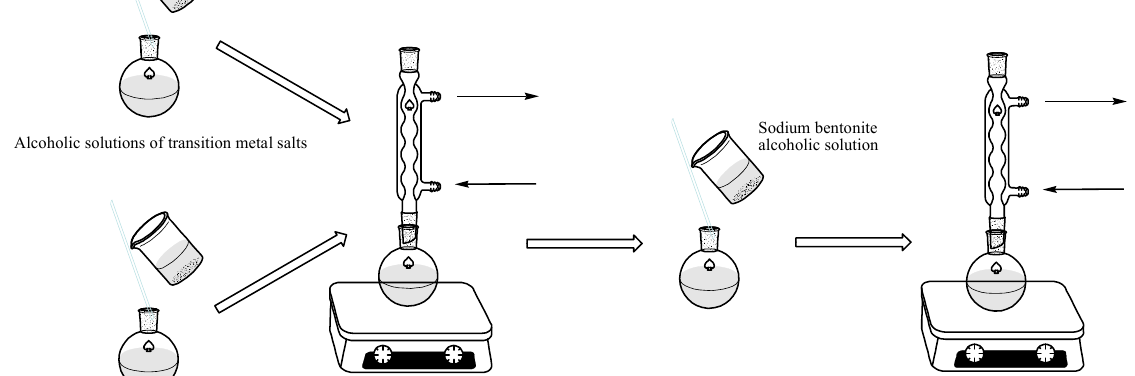
Figure 20. The synthesis process of NAD ‐ M.